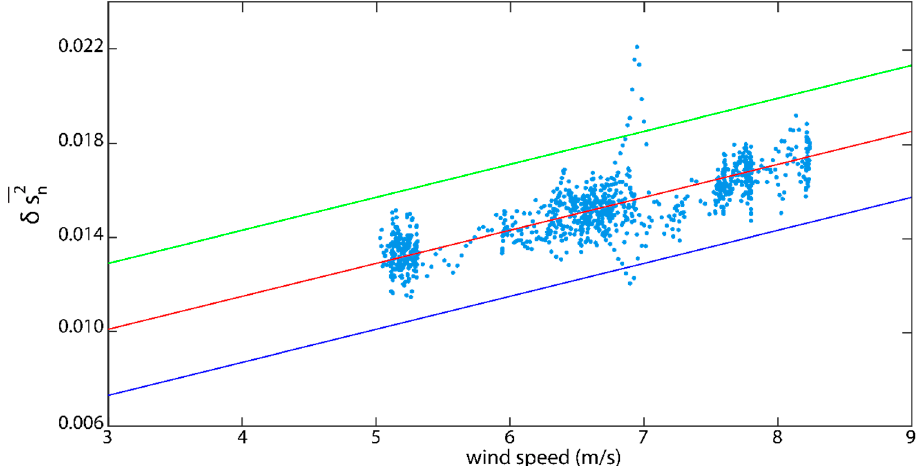
Figure 4. Differenced mean square slope parameter as a function of altimeter U 10 wind speed for relative orbit 152, cycle 036 over the tropical Atlantic off the Amazon shelf (descending orbit comprising latitudes approximately between 5.6 ° N and 2.6 ° N). The blue dots represent the 1024 altimeter samples for which the δ s 2 n and U 10 were computed.